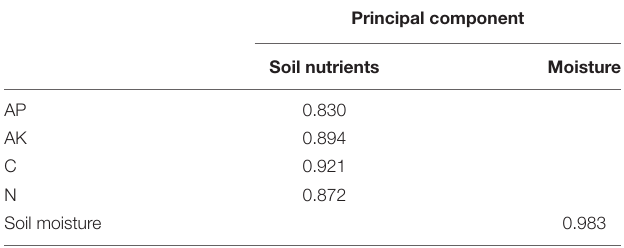
TABLE 4 | Principal component analysis score matrix of each soil property index.